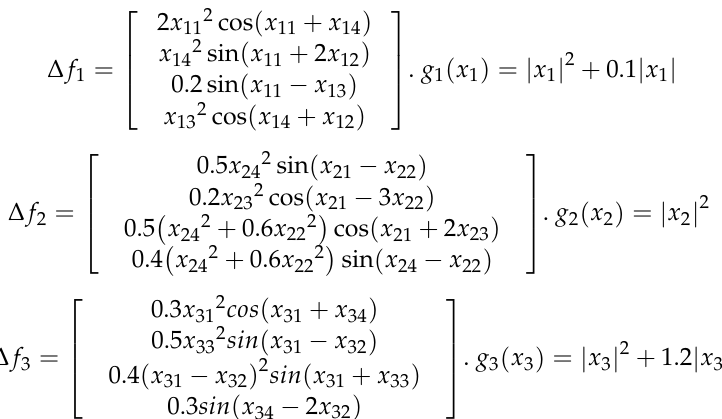
Figure 9. Estimation error curves for uncertainty ( right ) and disturbance ( left ) case (C). The chaotic behavior of systems is shown in Figure 10. The above figures exhibit the chaotic behavior of the master (green) and slave systems (blue and red). The presence of disturbance and uncertainty as well as changes in system parameters make the system behavior more complex. Chaotic behavior leads to the complicatedness of secure communications method and the possibility of detecting it is so low because in chaotic systems, in addition to un- certainty and disturbance, its parameters are assumed to be variable, which promotes the security of the approach.